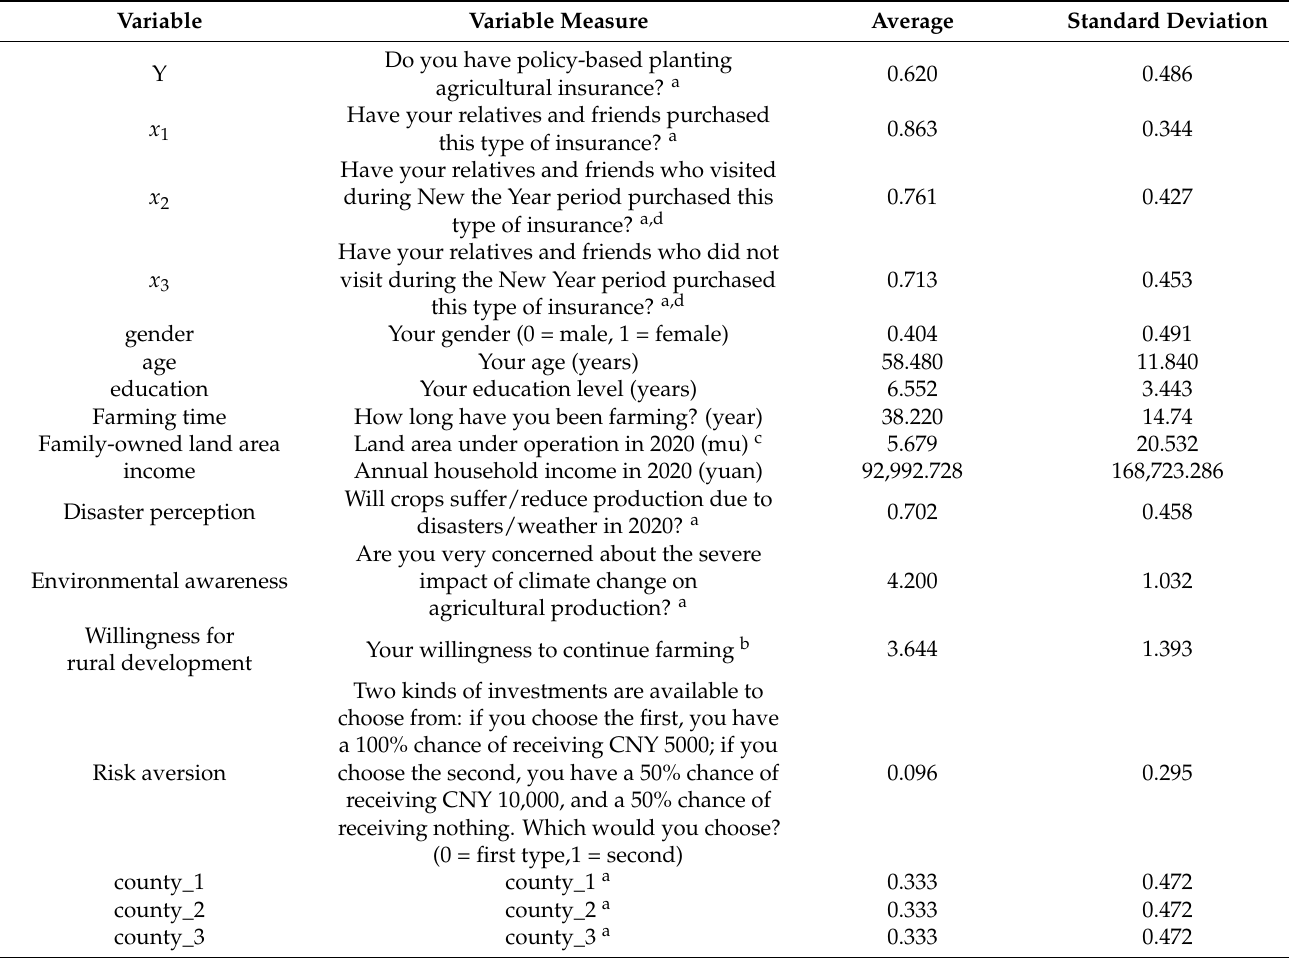
Table 1. Variable definitions and descriptive